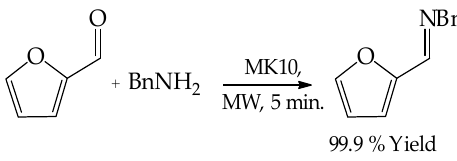
Scheme 1. Reaction of furfural with BnNH 2.